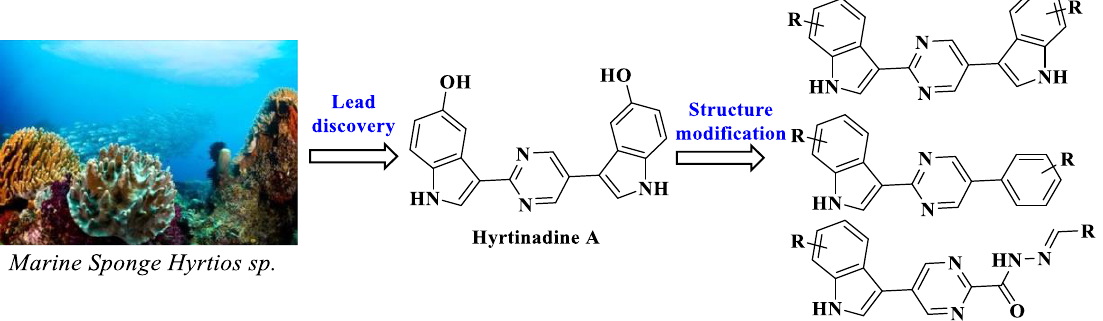
Figure 1. Design of hyrtinadine A derivatives.